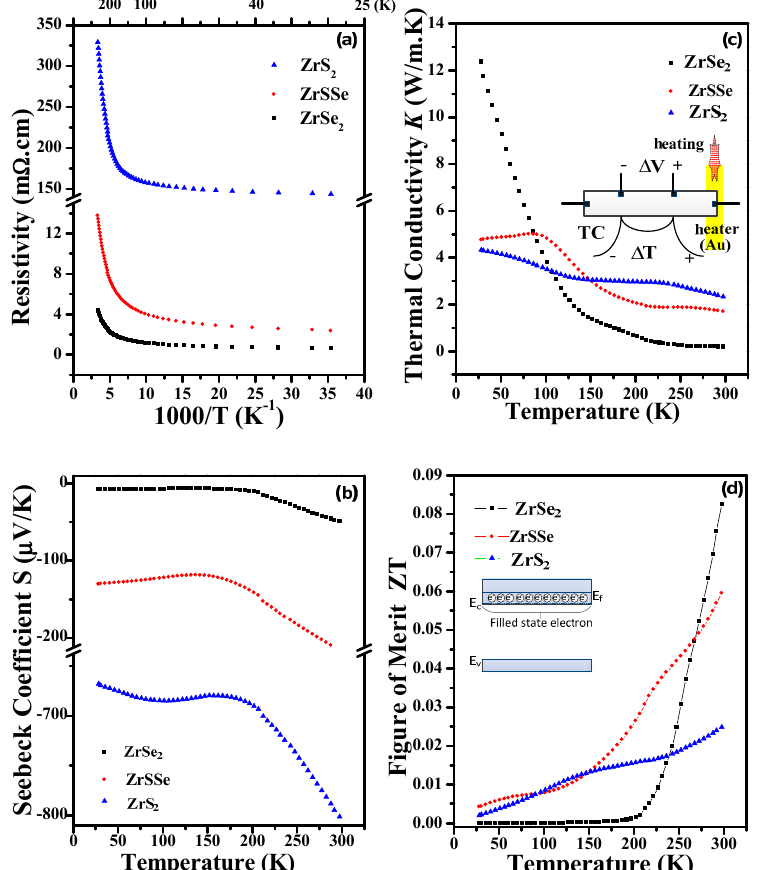
Figure 4. ( a ) Resistivity as function of reciprocal temperature. ( b ) Seebeck coefficient of ZrS 2 − x Se x (x = 0, 1, and 2) as function of temperature. ( c ) Thermal conductivity as function of temperature of ZrS 2 − x Se x (x = 0, 1, and 2). The inset shows the experimental configuration of thermoelectric measurement. ( d ) The dependences of ZT values (figure of merit) versus